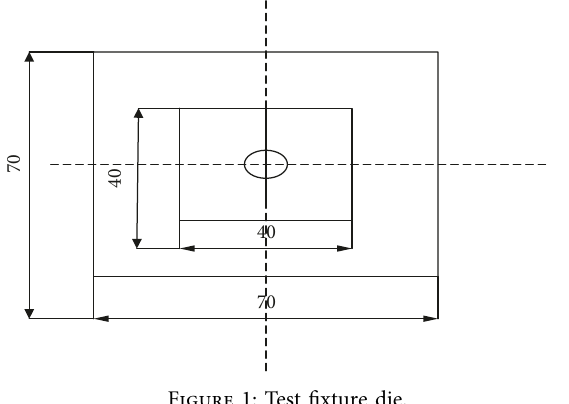
Figure 1: Test fixture die.